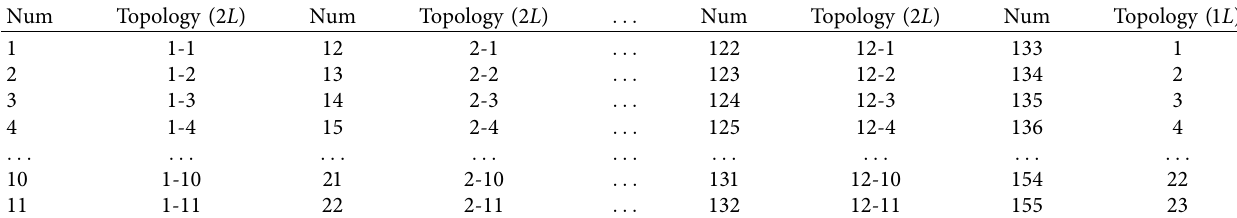
Table 2: Various configurations of trained ANNs.